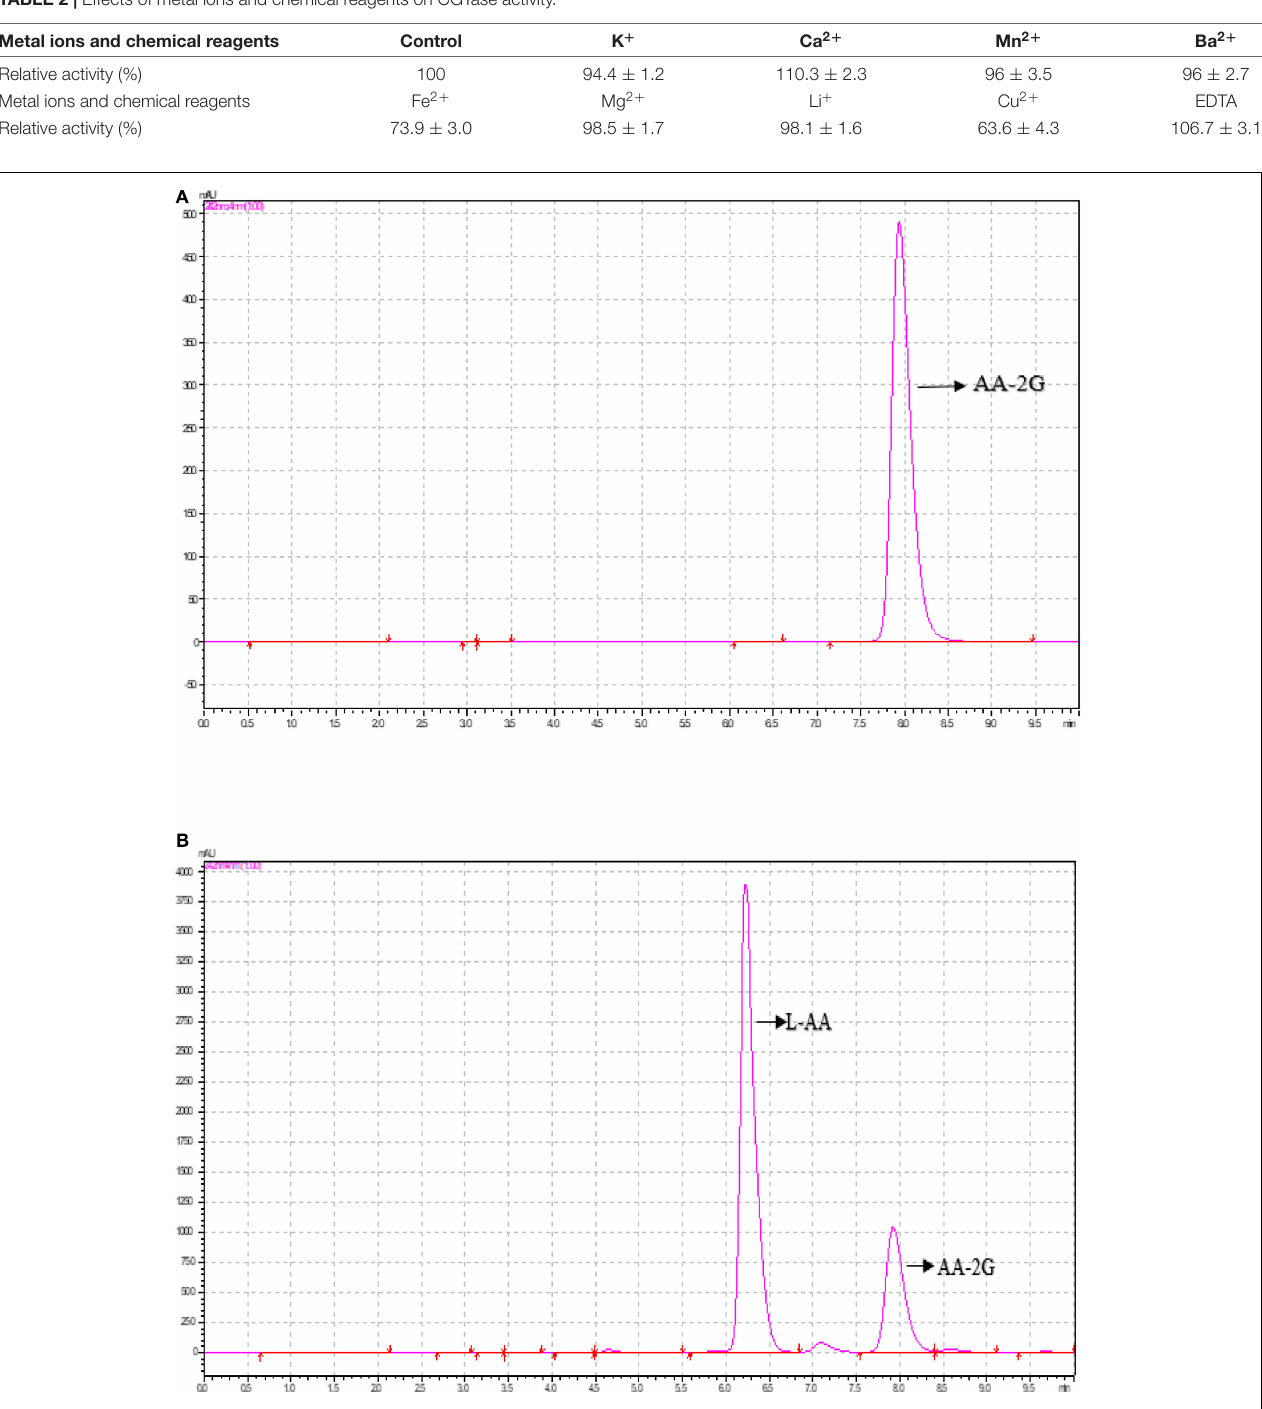
AA-2G by recombinant CGTase were explored. The experimental data were fitted to a ping-pong mechanism, which is consistent with the experimental results of Tao et al. (2018). The